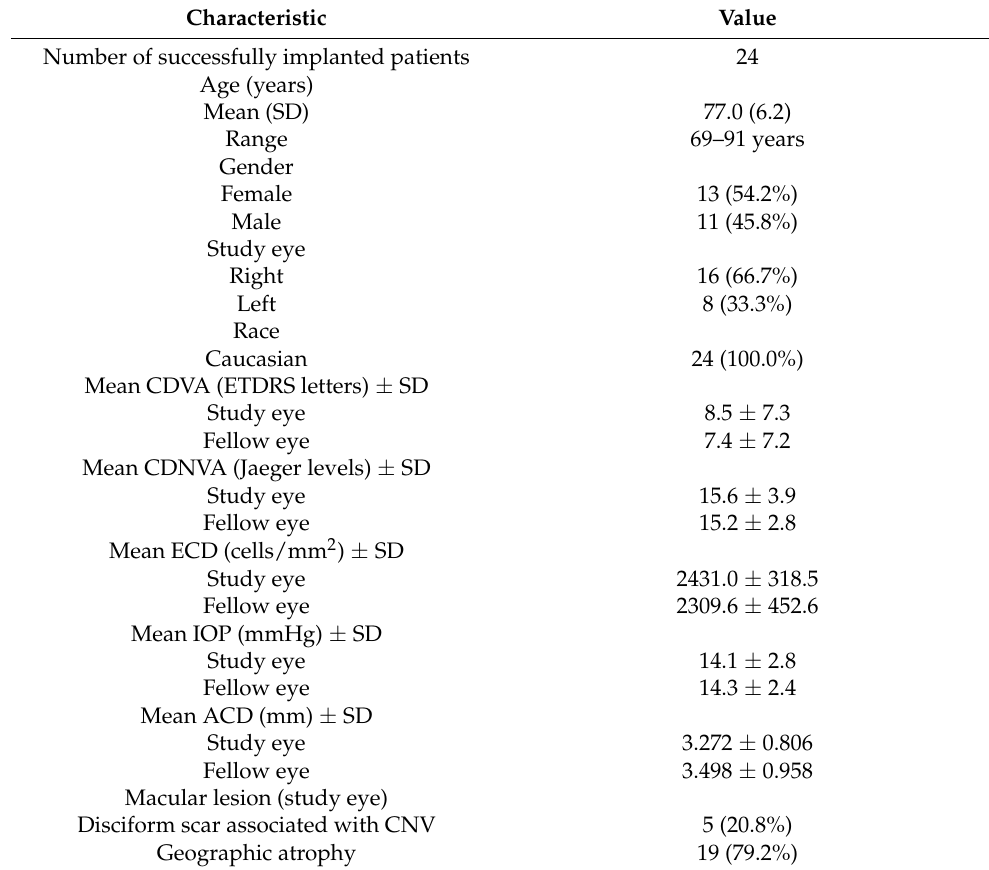
Table 1. Baseline demographics and clinical characteristics of the study